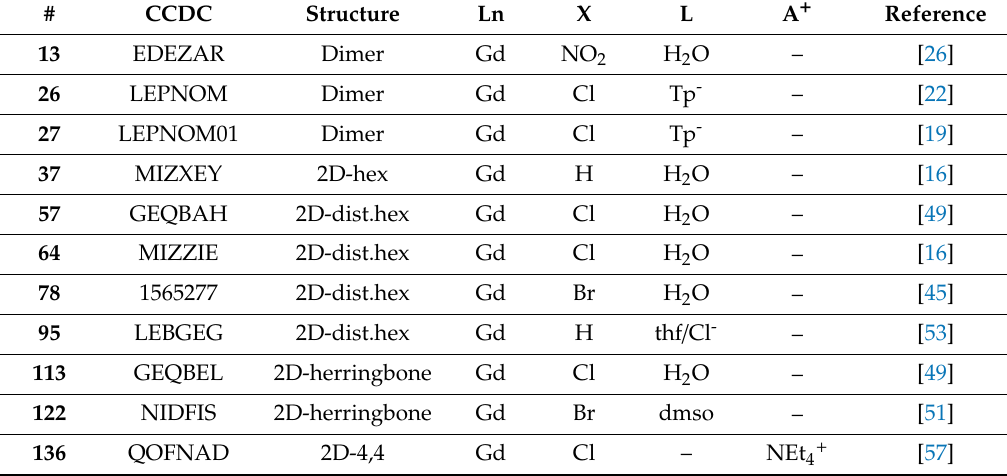
Table 20. Structurally characterized Gd(III) compounds with anilato